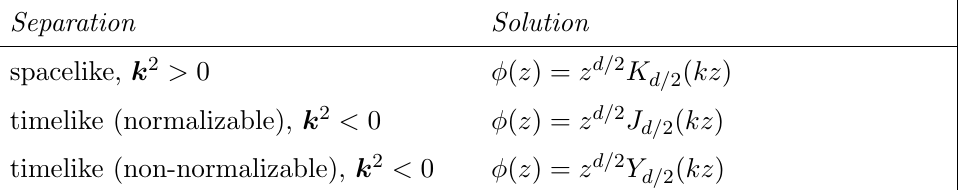
Table 1 . Solution to the equations of motion for scalar